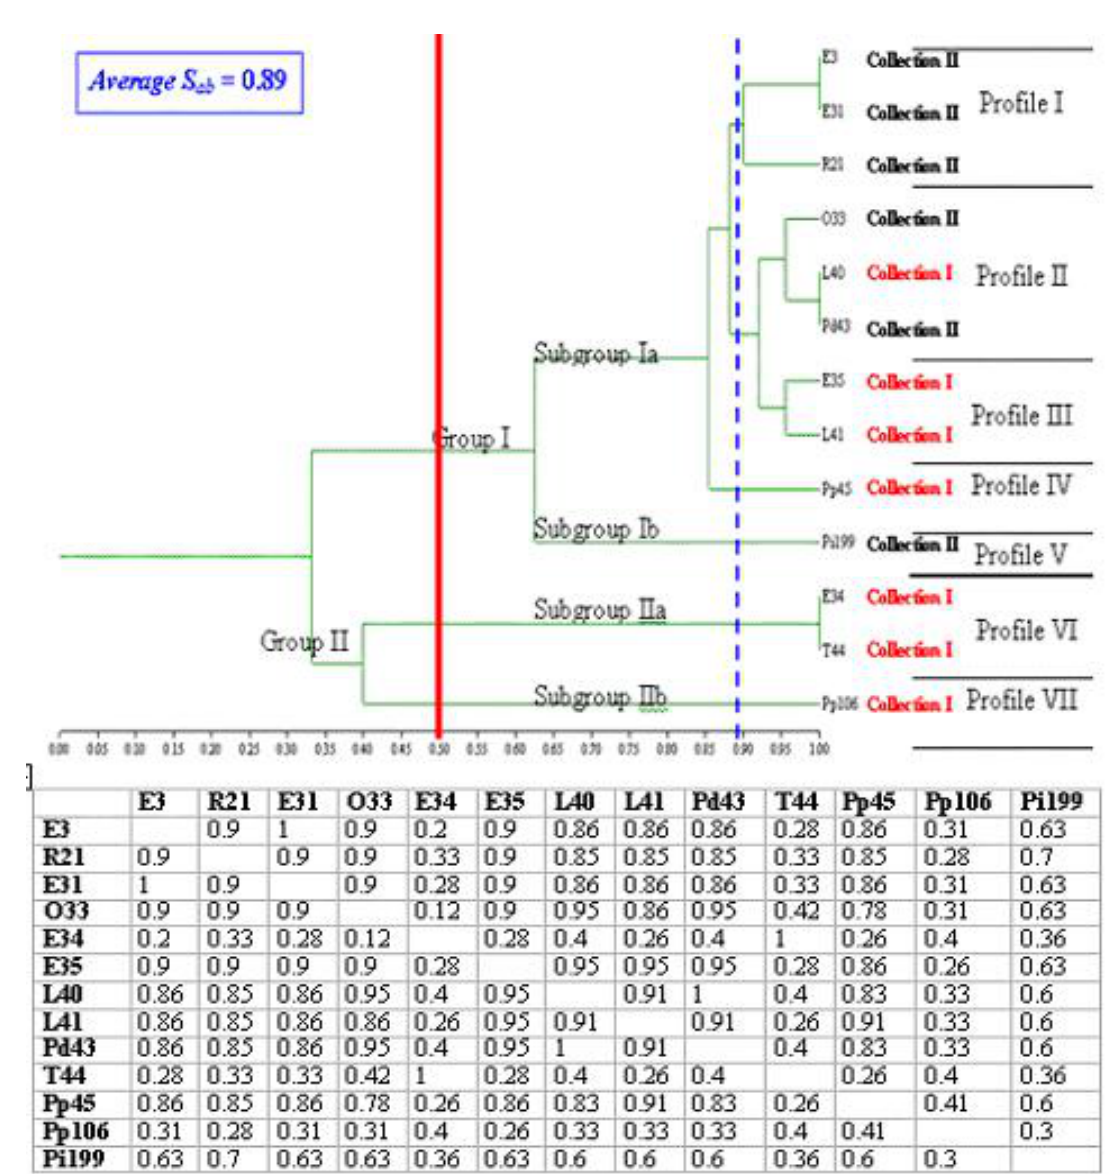
Figure 2. Dendrogram based on S coefficients, showing the genetic similarity, ab based on RAPD-PCR standards, of Klebsiella oxytoca with primer Operon 18 using the Sorensen-Dice coefficient. S average indicated by dotted line. ab Pi: isolates from lavatory basin; Pp: isolates from near lavatory basin; Pd: isolates away from lavatory basin; L: isolates from gloves; O: isolates from eyeglasses; T: isolates from tap; E: isolates from hand skins of surgeon-dentists; R: isolates from the